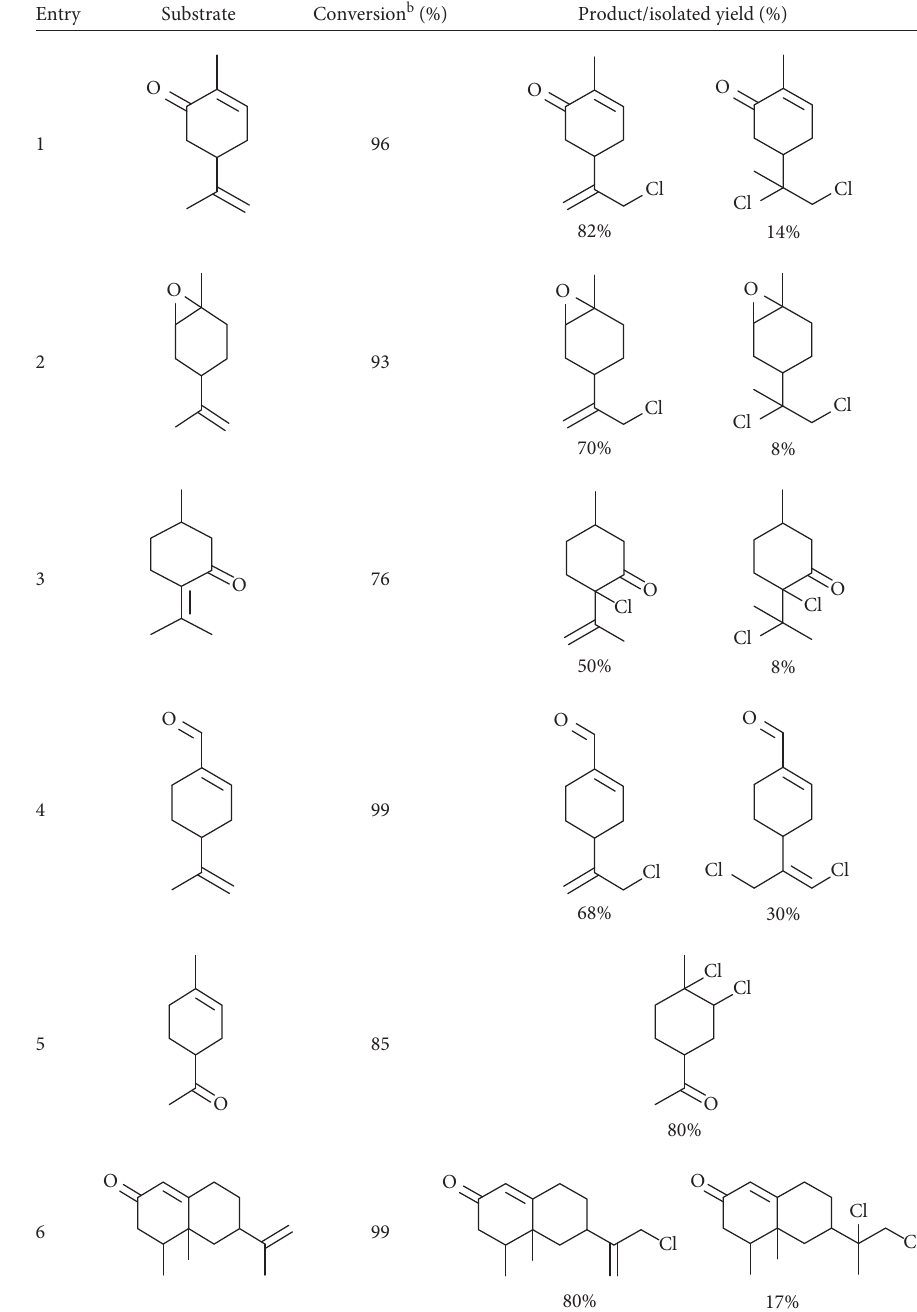
Table 3: Allylic chlorination of functionalized terpenes a